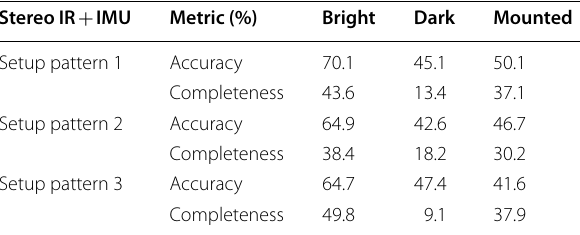
Table 14 Performance comparison of RTAB-Map (Stereo IR IMU) under different illumination conditions and setup + patterns Stereo IR +